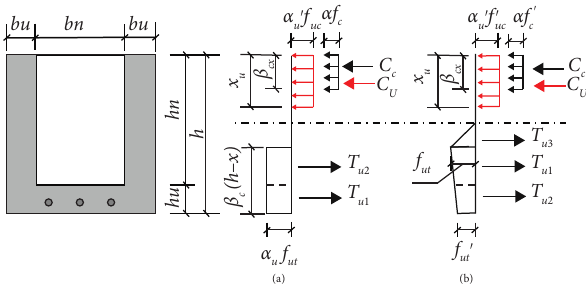
Figure 7: Te calculation mode of UHPC in the tension zone (a) One-stage type (b) Two-stage